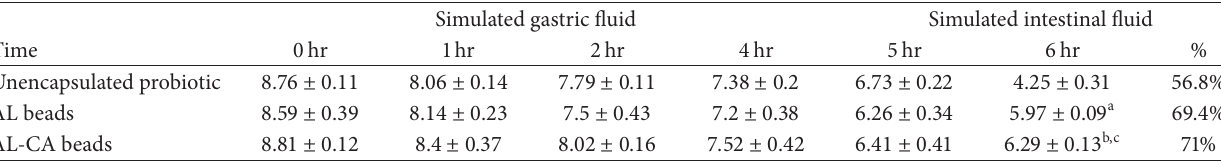
cfu) in Simulated Gastric fluid (SGF) and Simulated Intestinal fluid (SIF) ( 𝑛 = 6 ). 10